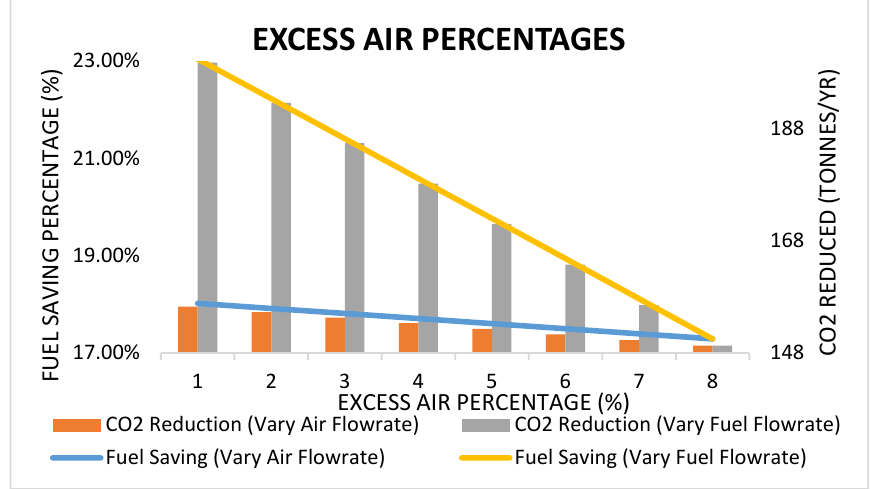
Figure 7. Fuel-Saving Percentage and CO2 Reduction under Different Excess Air Percentages